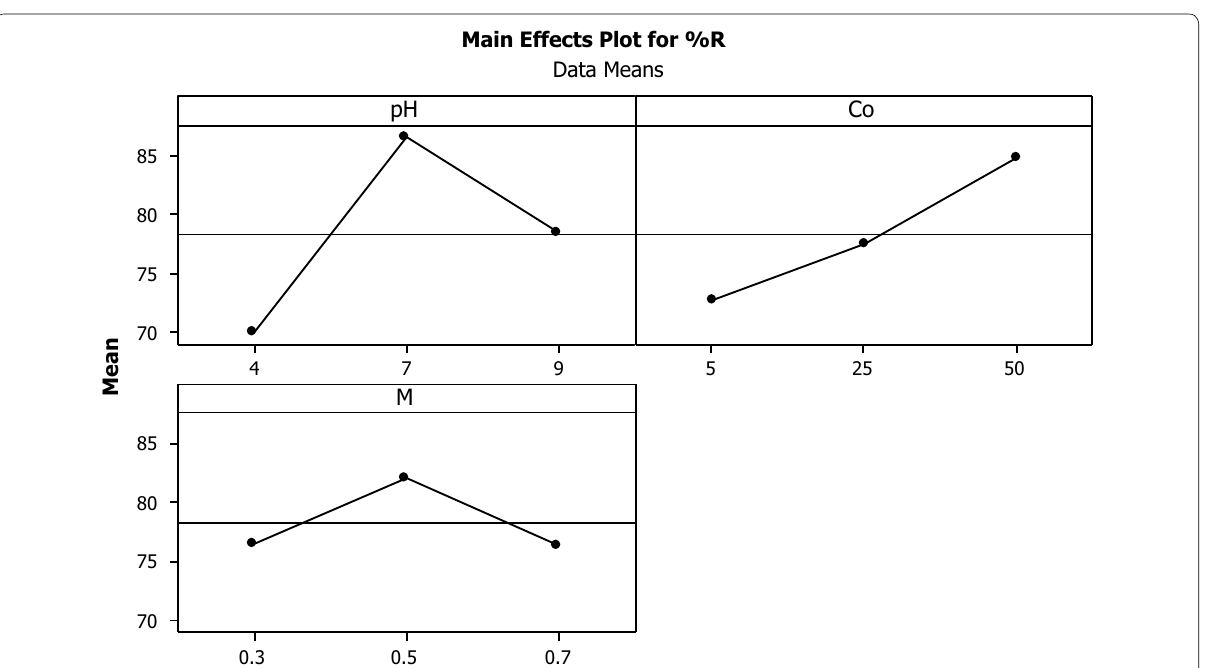
The linear plot of the Langmuir isotherm for bisacodyl adsorption by mesoporous silica is illustrated in Fig. 5.